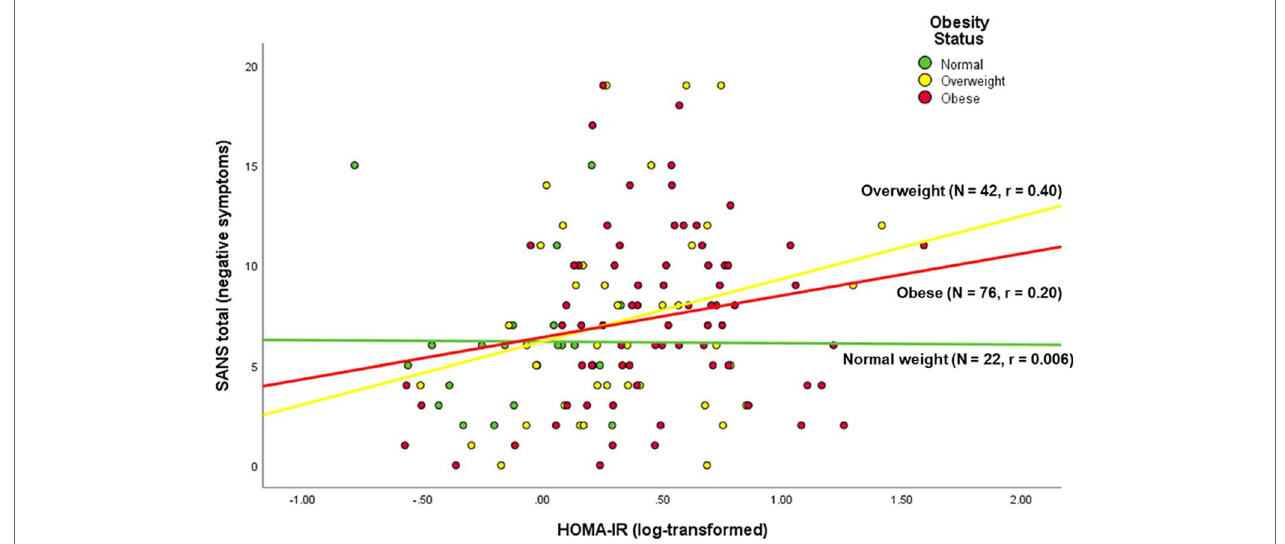
FIGURE 1 | Correlation of negative symptoms with insulin resistance in persons with schizophrenia, stratified by BMI